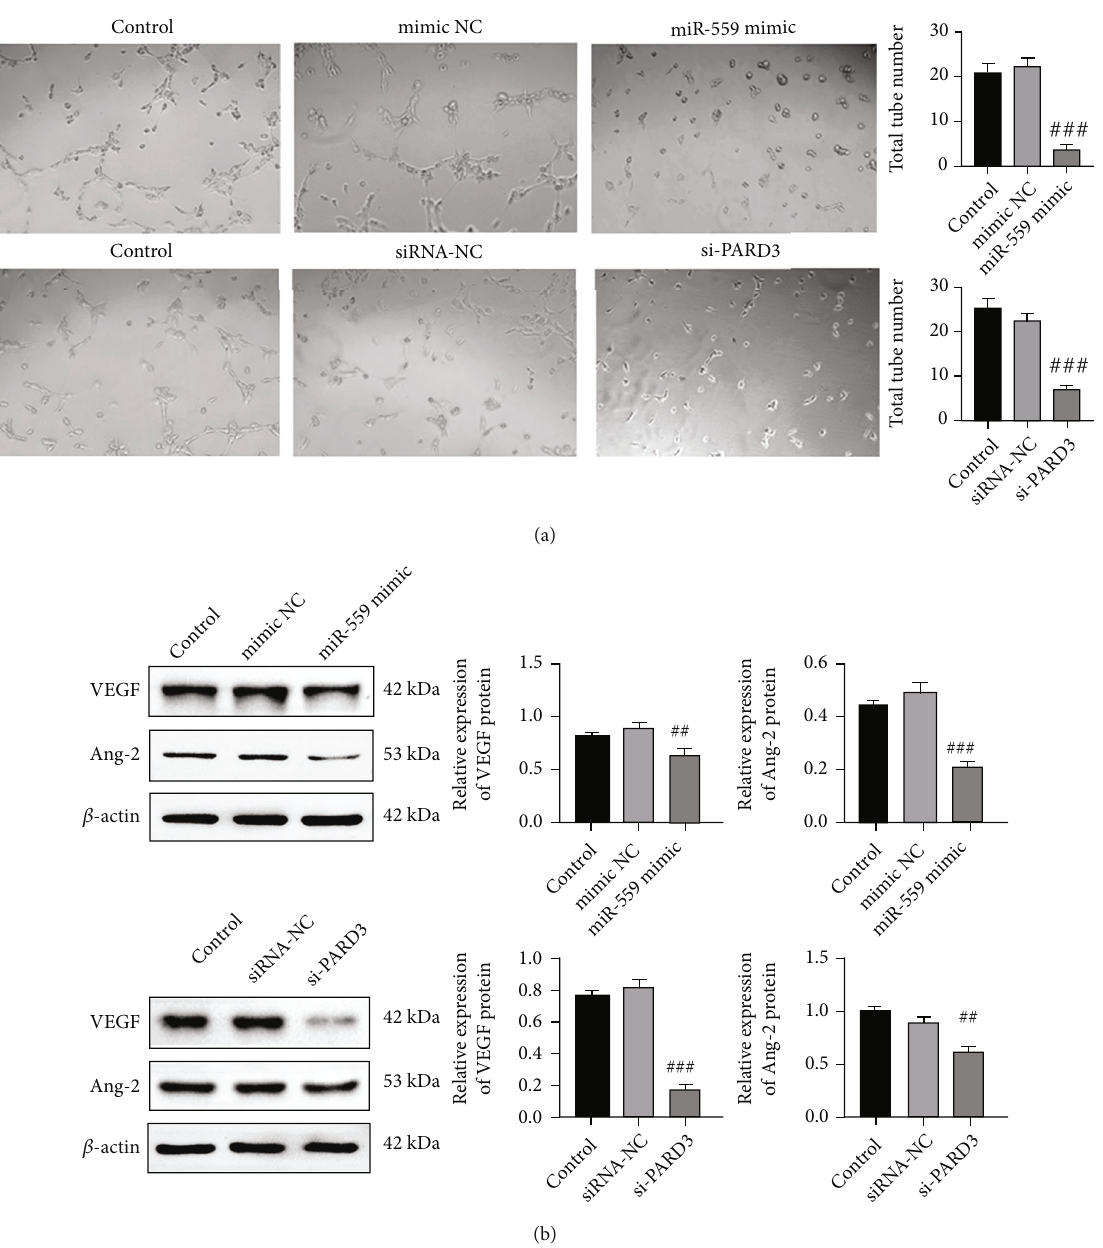
Figure 3: Overexpression of miR-559 or inhibition of PARD3 reduced the angiogenesis of Huh-7 cells. Huh-7 cells were transfected with miR-559 NC/mimics or si-RNA NC/PARD3 for 24 h. (a) In vitro HUVEC tube formation assay using conditioned medium and the quanti fi cation of tube length in each group. (b) Western blot analysis on the protein expressions of VEGF and Ang-2. The values were obtained from three independent experiments and shown as mean ± SD . ### p < 0 : 001 , compared with mimic NC or